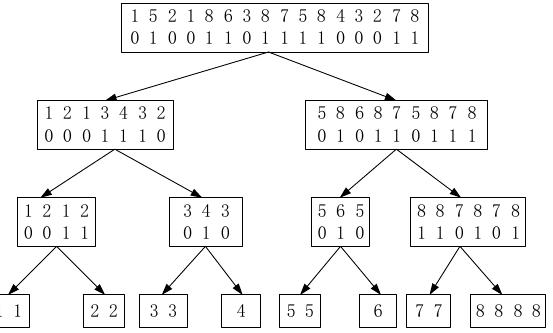
Figure 1. The wavelet tree for sequence 𝑆 = {1521863875843278} .